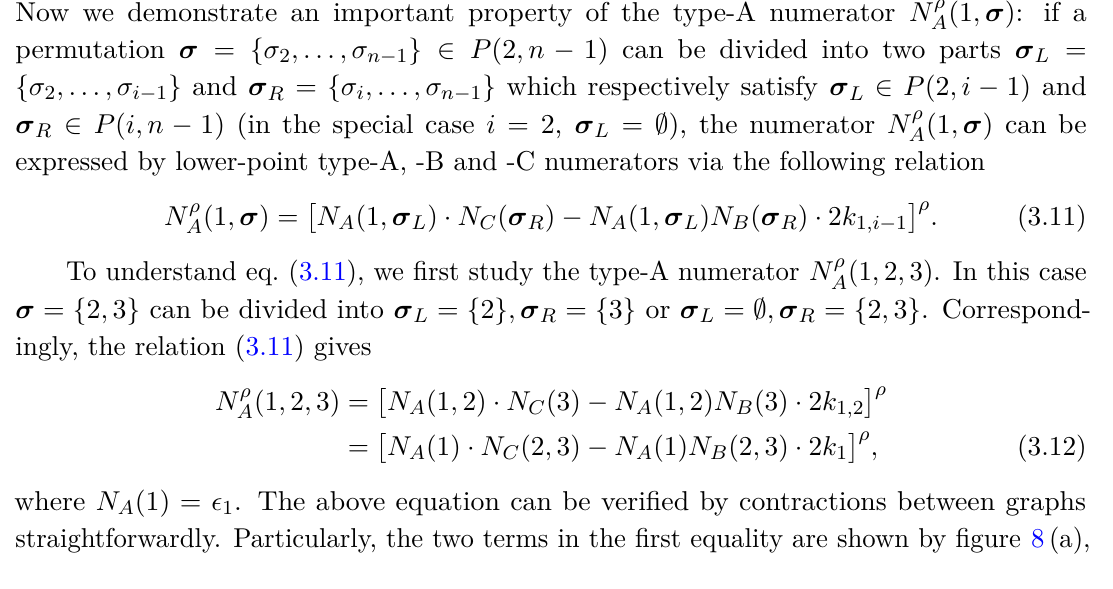
Table 2 . Contributions of graphs for all type-C numerators N νρ notation, e.g., (a)[1,2,3] stands for the graph which is obtained from figure 7 (a), via replacing x , y , and z by nodes 1 , 2 and 3 ,